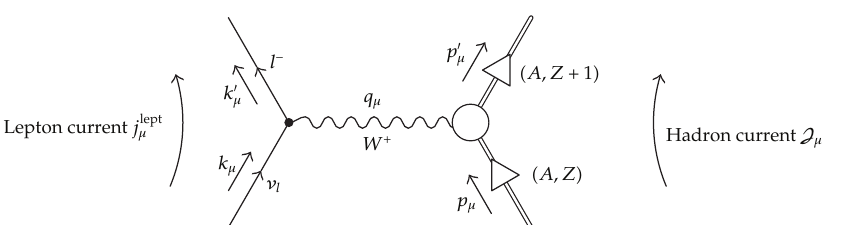
Figure 1: Charged-current neutrino scattering o ff a nucleus (cid:3) A,Z (cid:4) via the exchange of a W (cid:8) boson. The transferred four momentum is q μ (cid:7) k (cid:6)